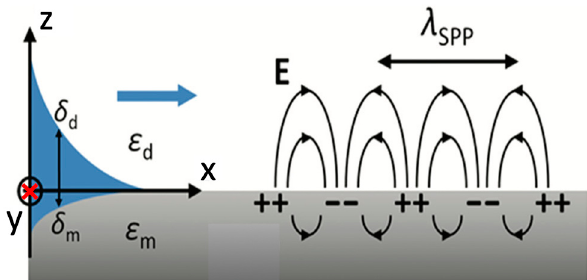
Figure 1. Demonstration of the layer geometry for propagating SPP generation. Adapted from [52], with permission from 2015 © The Royal Society of Chemistry.